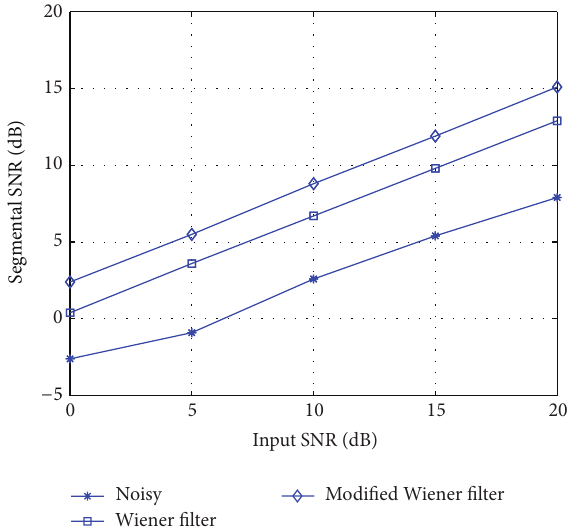
Figure 3: Results of segmental SNR measures of noisy signal, the Wiener filter, and the modified Wiener